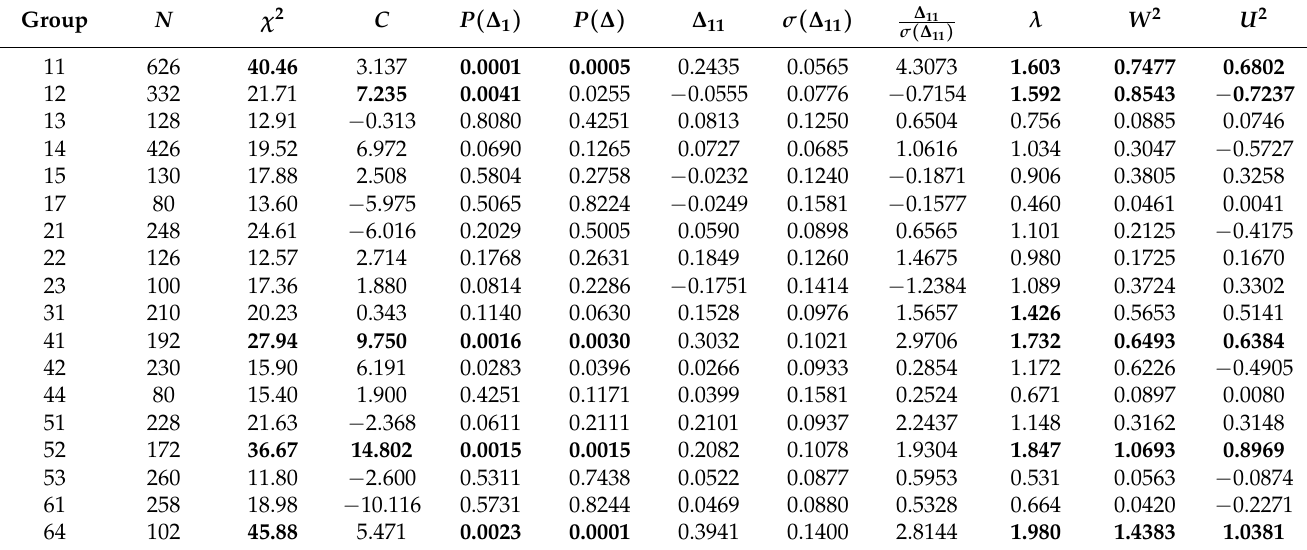
Table 6. Test for isotropy of the orientations of the galaxy plane. The distribution of the angle η of galaxies; inclination was calculated on the basis of the value of the parameter q 0 = 0.2 adding 3 ◦